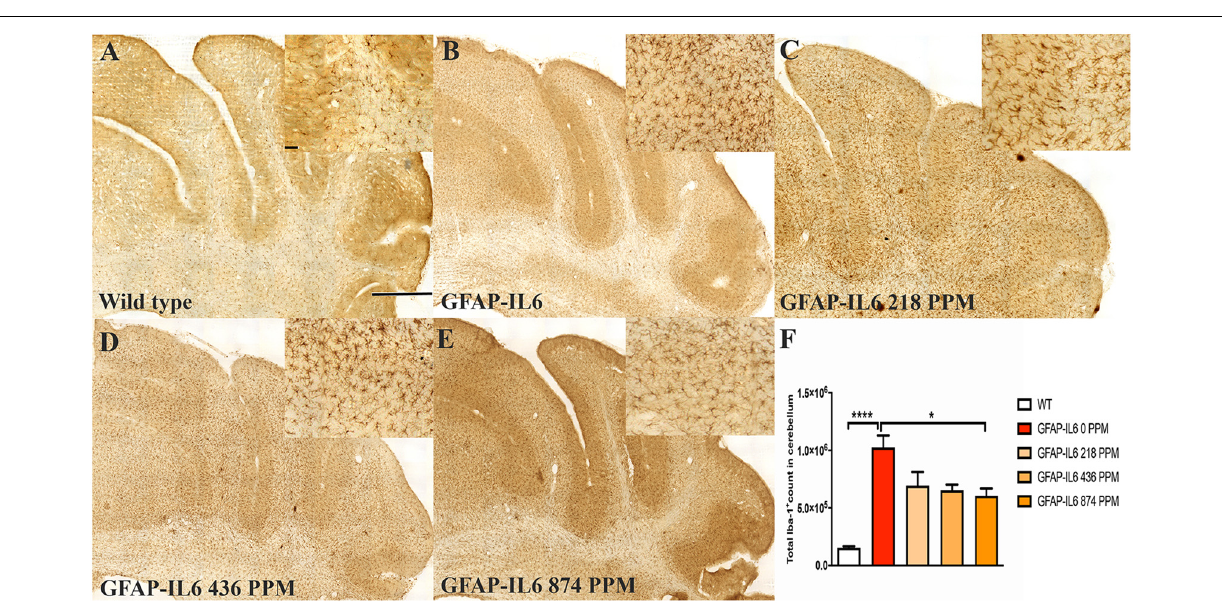
FIGURE 2 | MC decreased the number of Iba-1 + microglia in the cerebellum of GFAP-IL6 mice. (A–E) Representative photomicrographs of immunohistochemical staining for the microglia (Iba-1 + cells) of the cerebellum. (Magnification 10x objective field, scale bar = 500 µ m and 100 µ m in inserts). Images are representative of at least six animals per group ( n = 6). (F) Graphical representation of total Iba-1 + count in the cerebellum. The graph represents the mean ± SEM and significant differences were determined using one-way analysis of variance (ANOVA). Significance = **** p < 0.0001, * p <